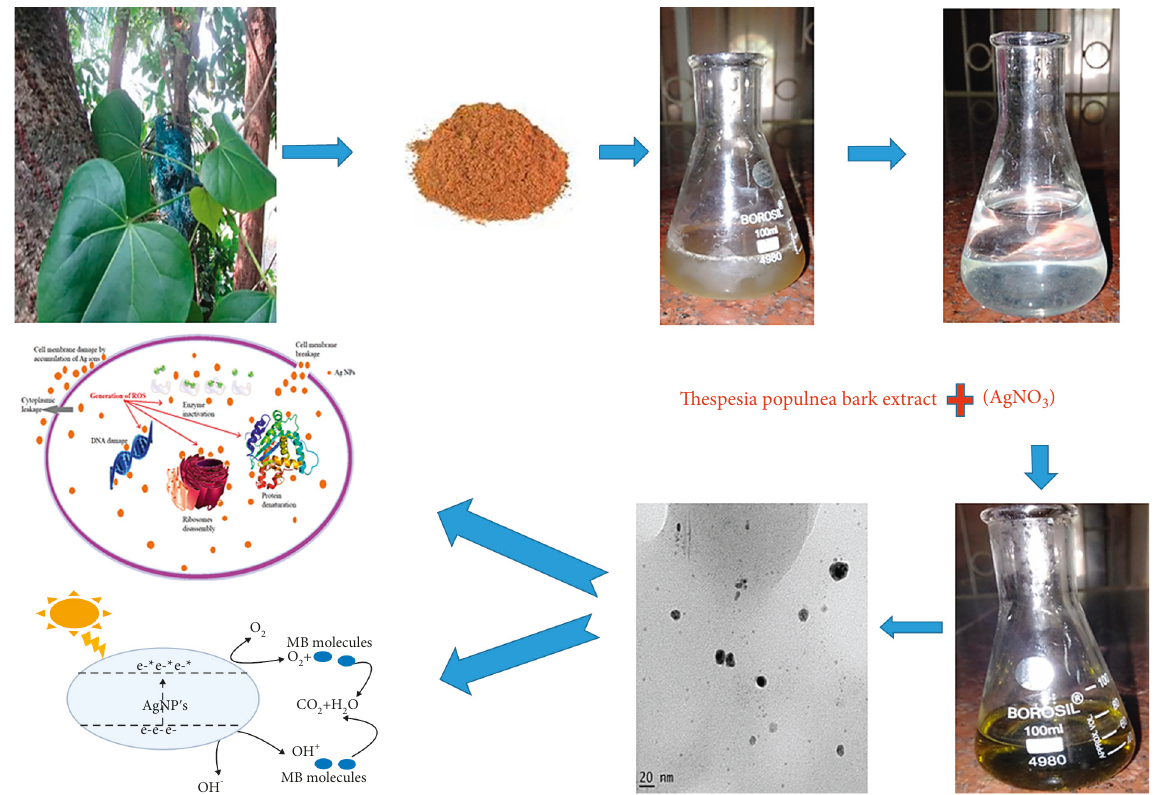
Figure 1: Synthesis of Ag-NPs using Thespesia populnea bark